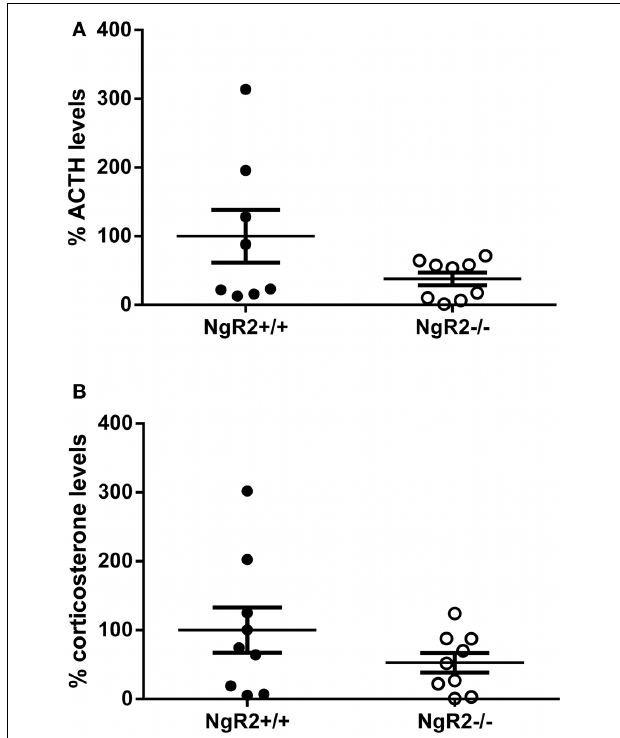
FIGURE 4 | Basal ACTH and corticosterone levels in NgR2 − / − mice. (A) Basal ACTH measurements normalized to NgR2 + / + . (B) Basal corticosterone measurements normalized to NgR2 + / + . n = 8–9/genotype for ACTH, n = 9/genotype for corticosterone, data pooled from 2 cohorts of